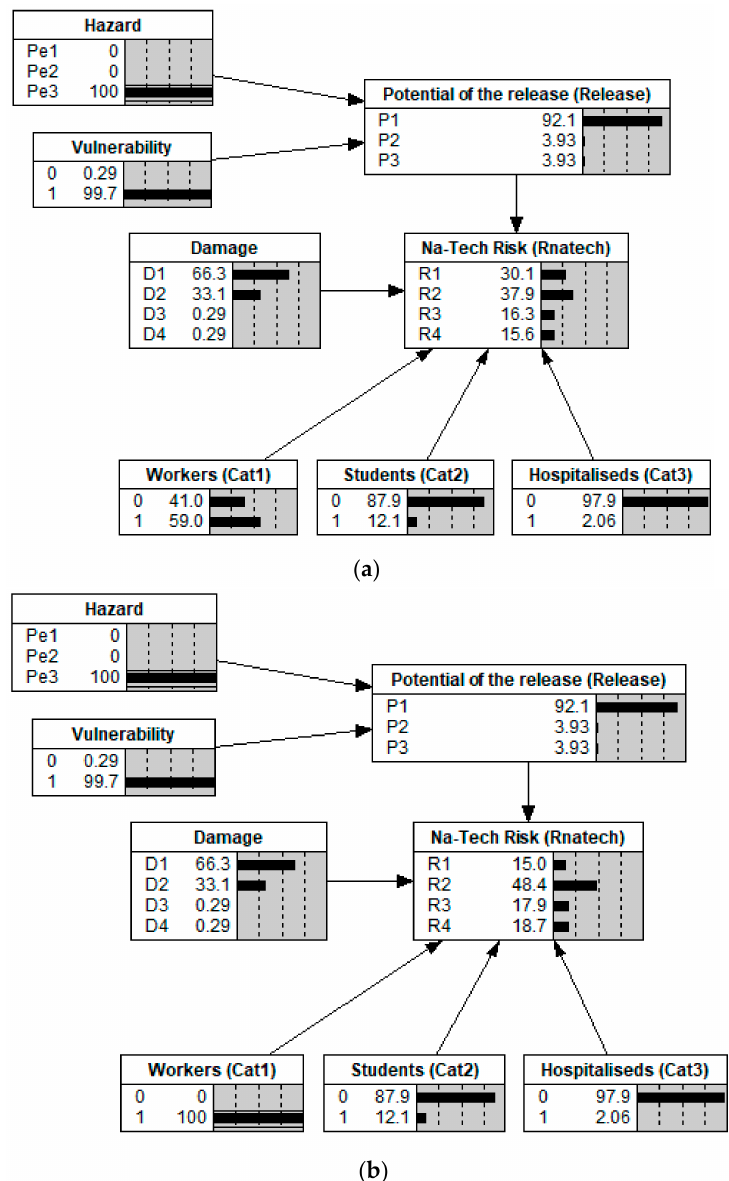
Figure 9. Changes in the target node due to the occurrence of a flood event ( a ) evidence on the “hazard” node for the occurrence of an event Pe3 ; ( b ) evidence on the “workers” node for the presence of